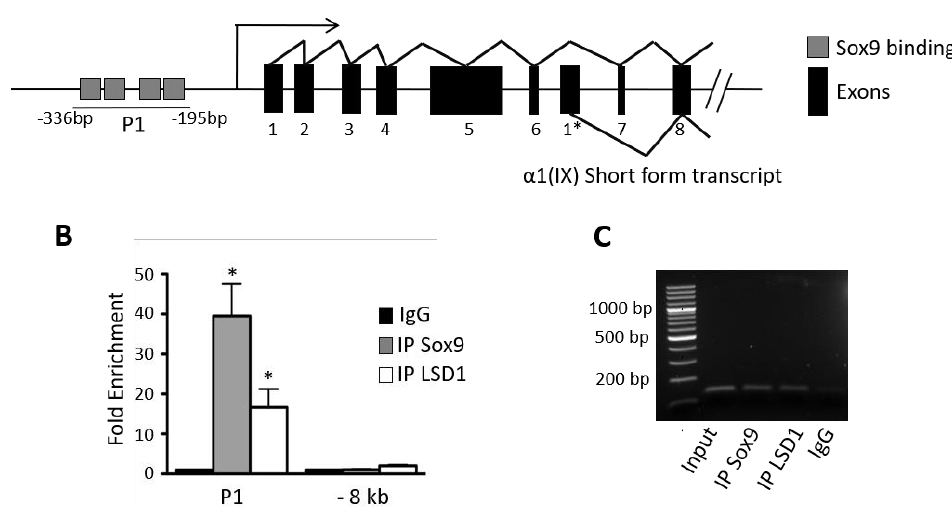
Figure 4. LSD1 is recruited onto the COL9A1 promoter region. ( A ) Schematic representation of the COL9A1 promoter which contains four SOX9 binding sites arranged in two pairs. Primers used for PCR are indicated (denoted P1 and -8kb). ( B ) Immunoprecipitation of chromatin was done using anti-SOX9 or anti-LSD1 antibody from human articular chondrocytes. Then, real-time PCR was performed using specific primers P1 of the COL9A1 promoter regions or 8kb upstream ( n = 3, Student’s t -test * p < 0.05). ( C ) Agarose gel shows the corresponding PCR products using the P1 primers .